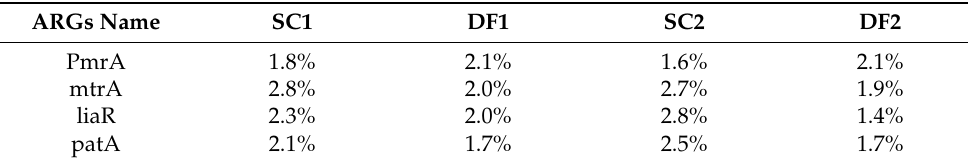
Figure 4. The differences in relative abundance of ARG subtypes between SC and DF samples based on Chi-square test. ( a ) CD plant; ( b ) CN plant (* means 0.01 < p ≤ 0.05, ** means 0.001 < p ≤ 0.01, *** means p ≤ 0.001). Table 1. ARGs subtypes with the same trend through D-Type